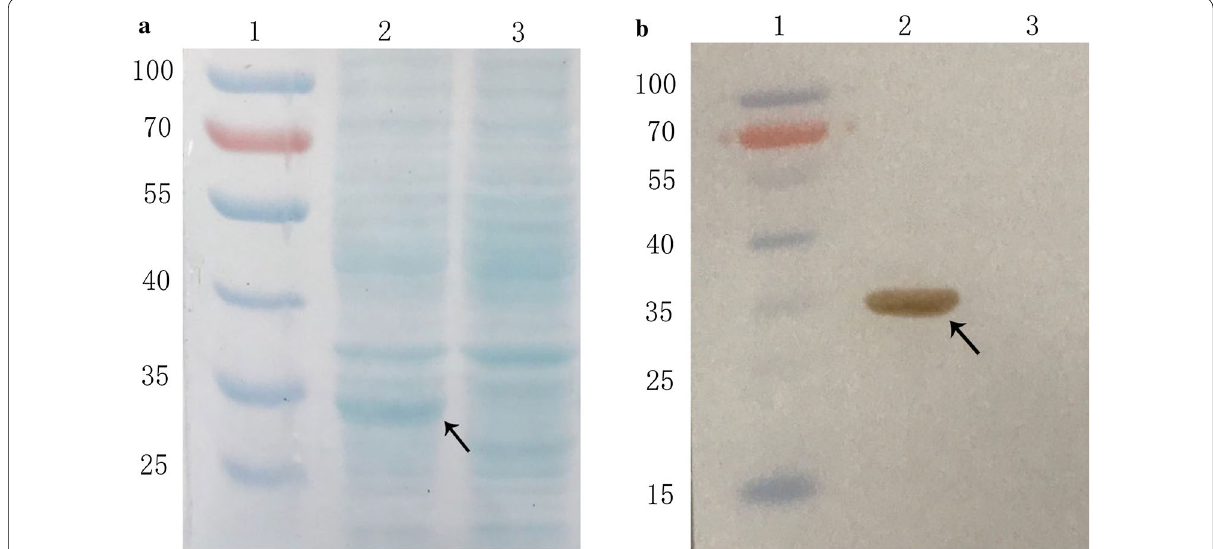
Fig. 2 SDS-PAGE and Western blot of recombinant mutant Staphylococcal enterotoxin B in E. col i BL21. a SDS-PAGE (12%) of mSEB in E. coli BL21. Lane 1: prestained protein markers, Lane 2: lysate of the bacterial with recombinant plasmid pET28a-mSEB induced with IPTG, lane 3: lysate of the bacterial with parent pET28a plasmid induced with IPTG. b Western blot of mSEB in E.coli BL21. Lane 1: prestained protein markers, Lane 2: lysate of the bacterial with recombinant plasmid pET28a-mSEB, Lane 3: lysate of the bacterial with parent pET28a plasmid; The arrows indicate the target